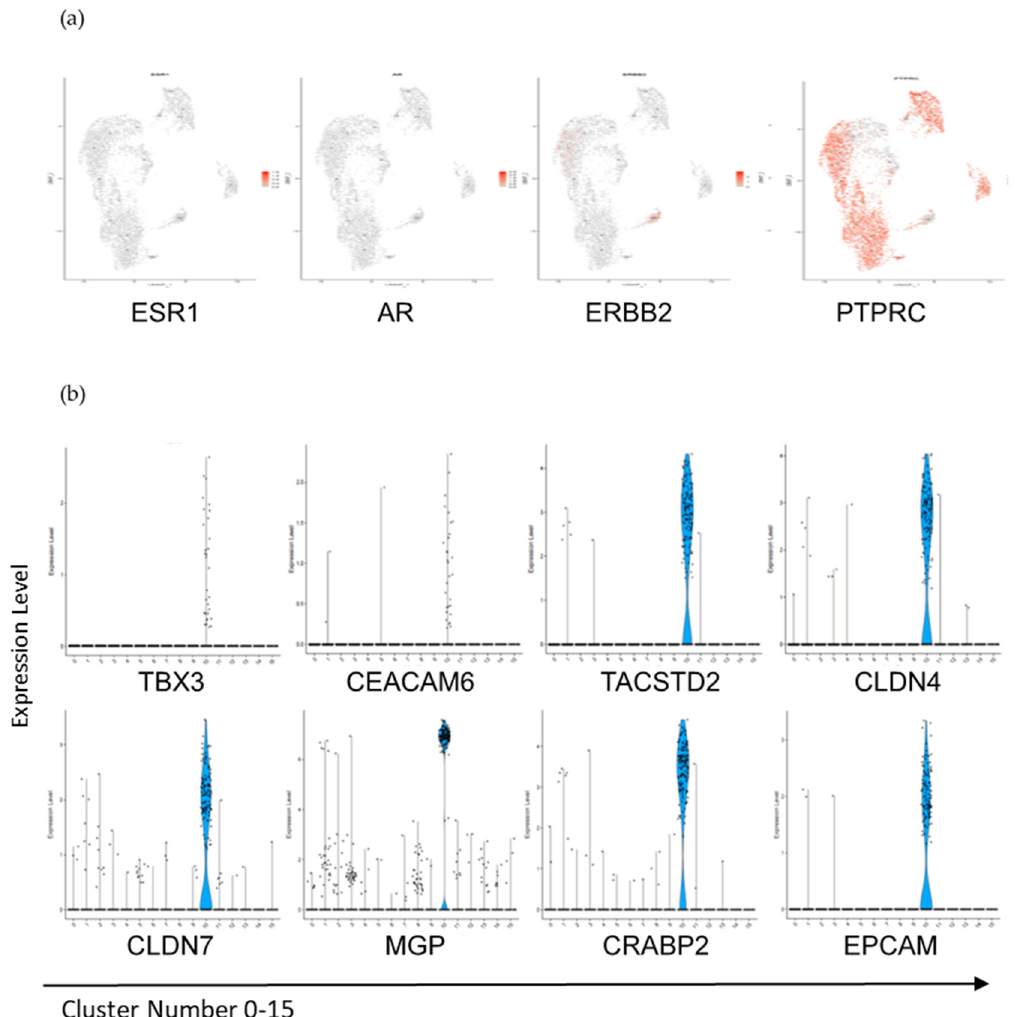
Figure 6. Significant gene expression within 10x Chromium cluster 10. ( a ) UMAPs displaying a differential gene expression of ER/PR/HER2 (ERBB2) and EpCAM identifying cluster 10 as non-immune cells. Few cells expressing these hormone-receptor genes were detected in cluster 10, however they were also expressed in other clusters. The scale of expression levels is shown for each gene. ( b ) Violin plots displaying genes of interest, which were significantly upregulated in cluster 10 when compared to other clusters. Claudin 4 (CLDN4) and Claudin 7 (CLDN7) while (TACSTD2), TBX3, and CEACAM6 were significantly expressed in cluster 10 (CTCs) with a minimal expression in the other clusters. Matrix Gla protein (MGP) and cellular retinoic acid binding protein 2 (CRABP2) were highly upregulated in cluster 10, with low-level expression in remaining clusters.